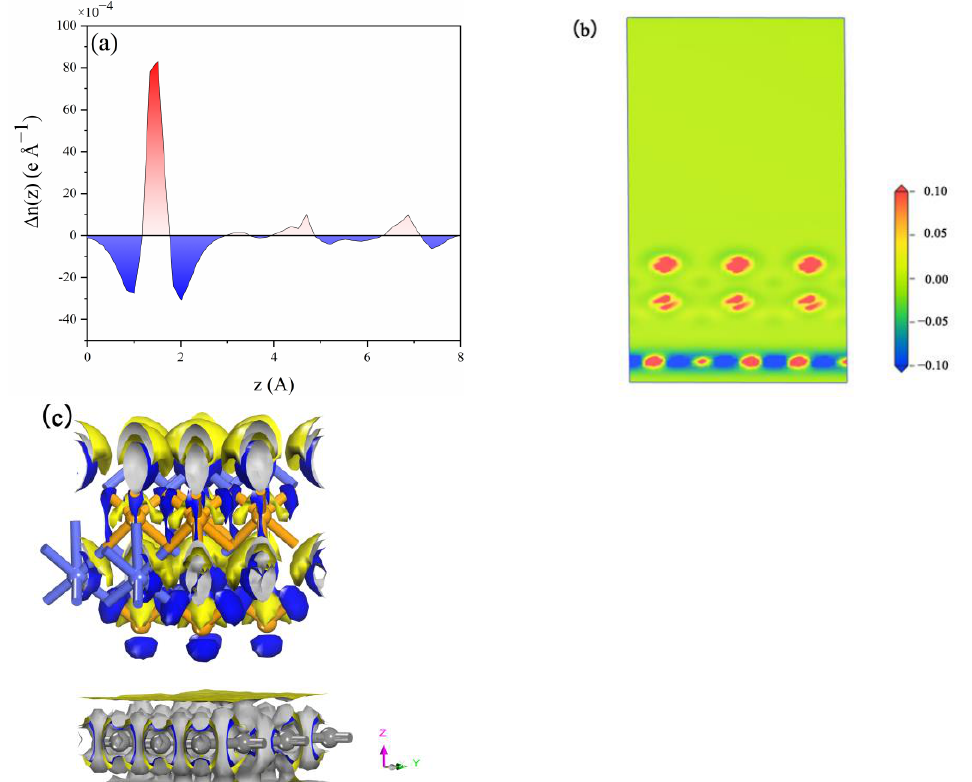
Figure 9. ( a ) CS/yNC@X differential charge density map, ( b ) CS/yNC@X differential charge section map, ( c ) heterostructure electrostatic potential distribution map.